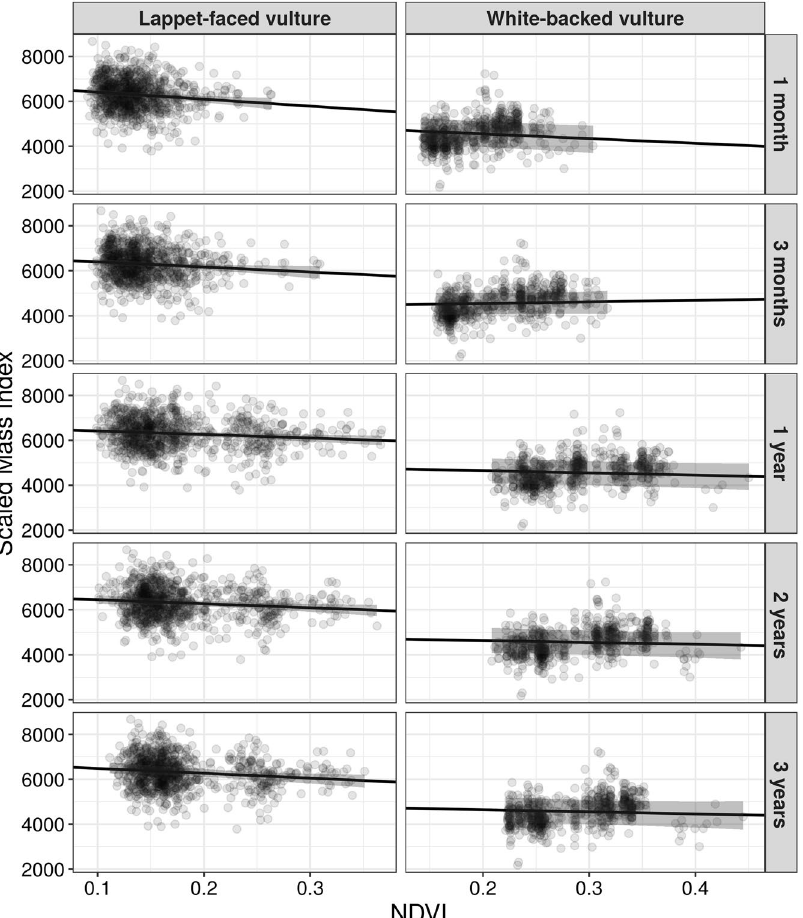
Figure 2. The relationship between the body condition of lappet-faced (left panels) and white-backed (right panels) vulture nestlings and the normalized difference vegetation index (NDVI). We explored NDVI effects across five temporal scales representing the situation during the one month prior to nestling measurement (uppermost row) and up until 3 years prior to the measurement (lowermost row). Each panel shows the raw data (circles) and the fitted linear relationship obtained from the Bayesian hierarchical models (straight black line, with 95% credibility intervals shown as grey shade; see methods and Table